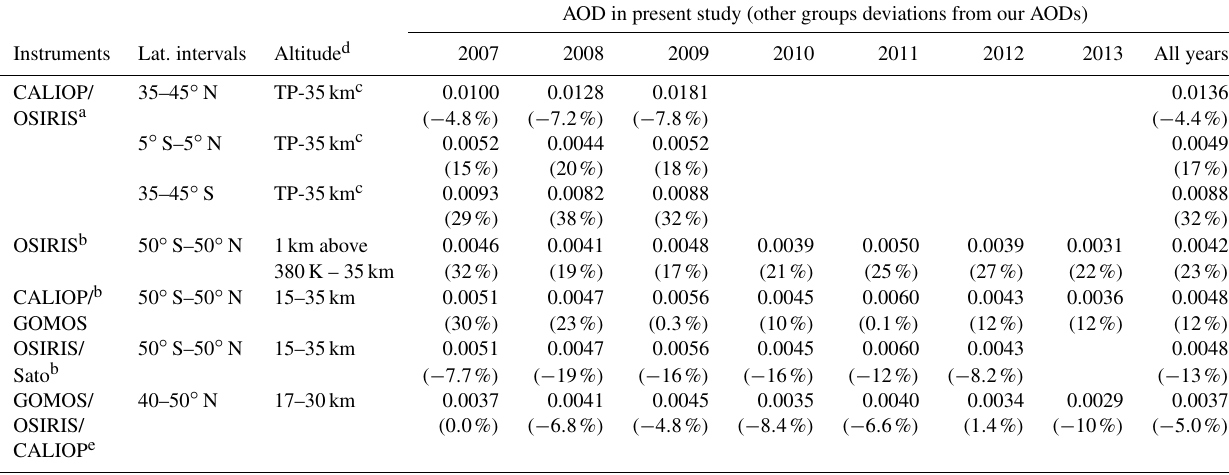
Table 2. Comparison of the annual mean AODs from our study and other studies, for the years 2007–2013 and various latitude intervals. AOD in present study (other groups deviations from our AODs) Instruments